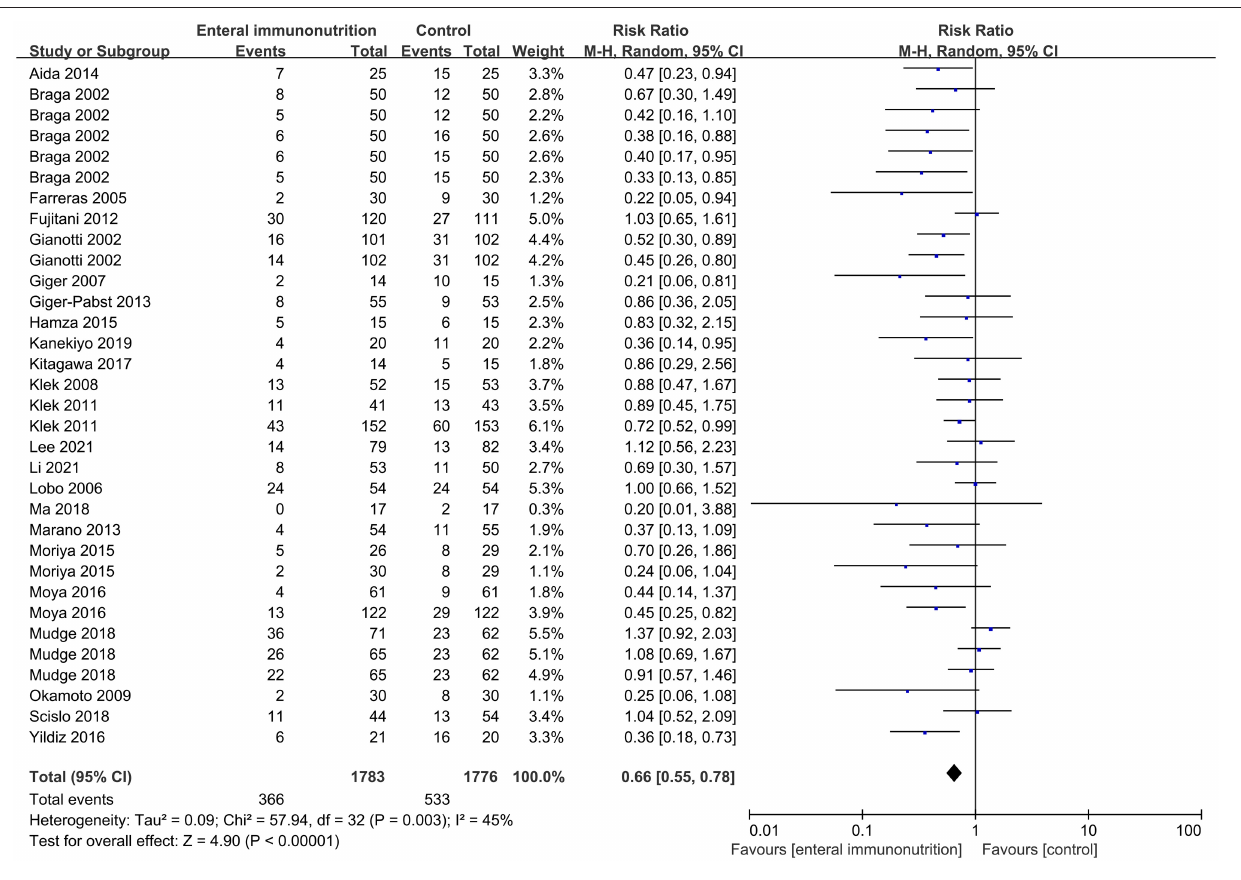
FIGURE 3 | Forest plot of meta-analysis of infectious